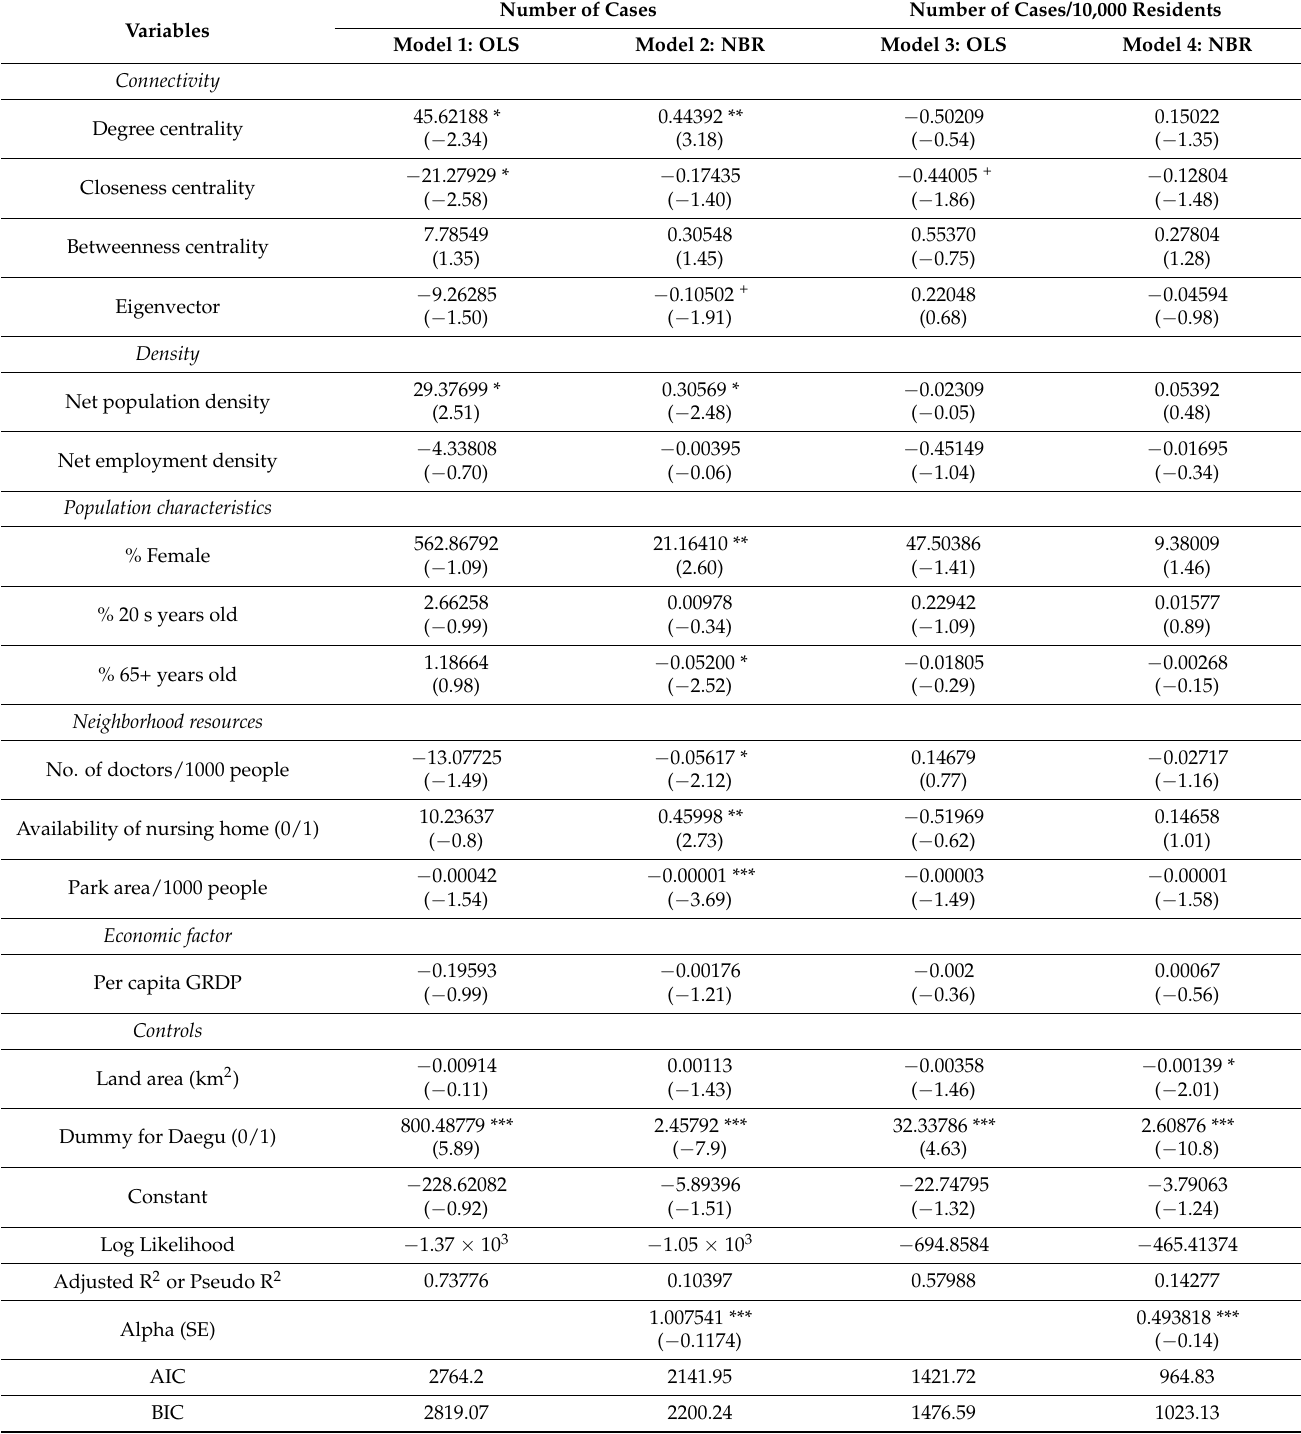
Table 3. OLS and negative binomial regression (NBR) models of the district level COVID-19 cases ( n =